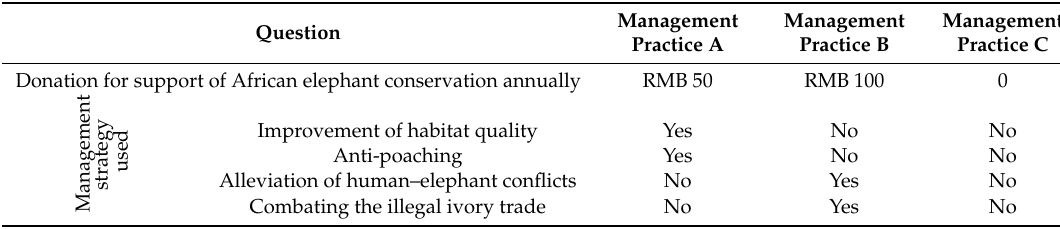
Table 2. Sample choice experiment presented in the